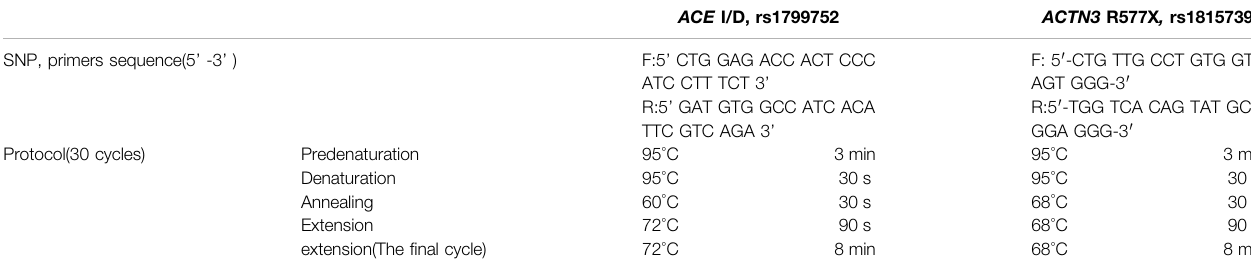
TABLE 1 | Primers and PCR conditions for polymorphism of ACE and ACTN3